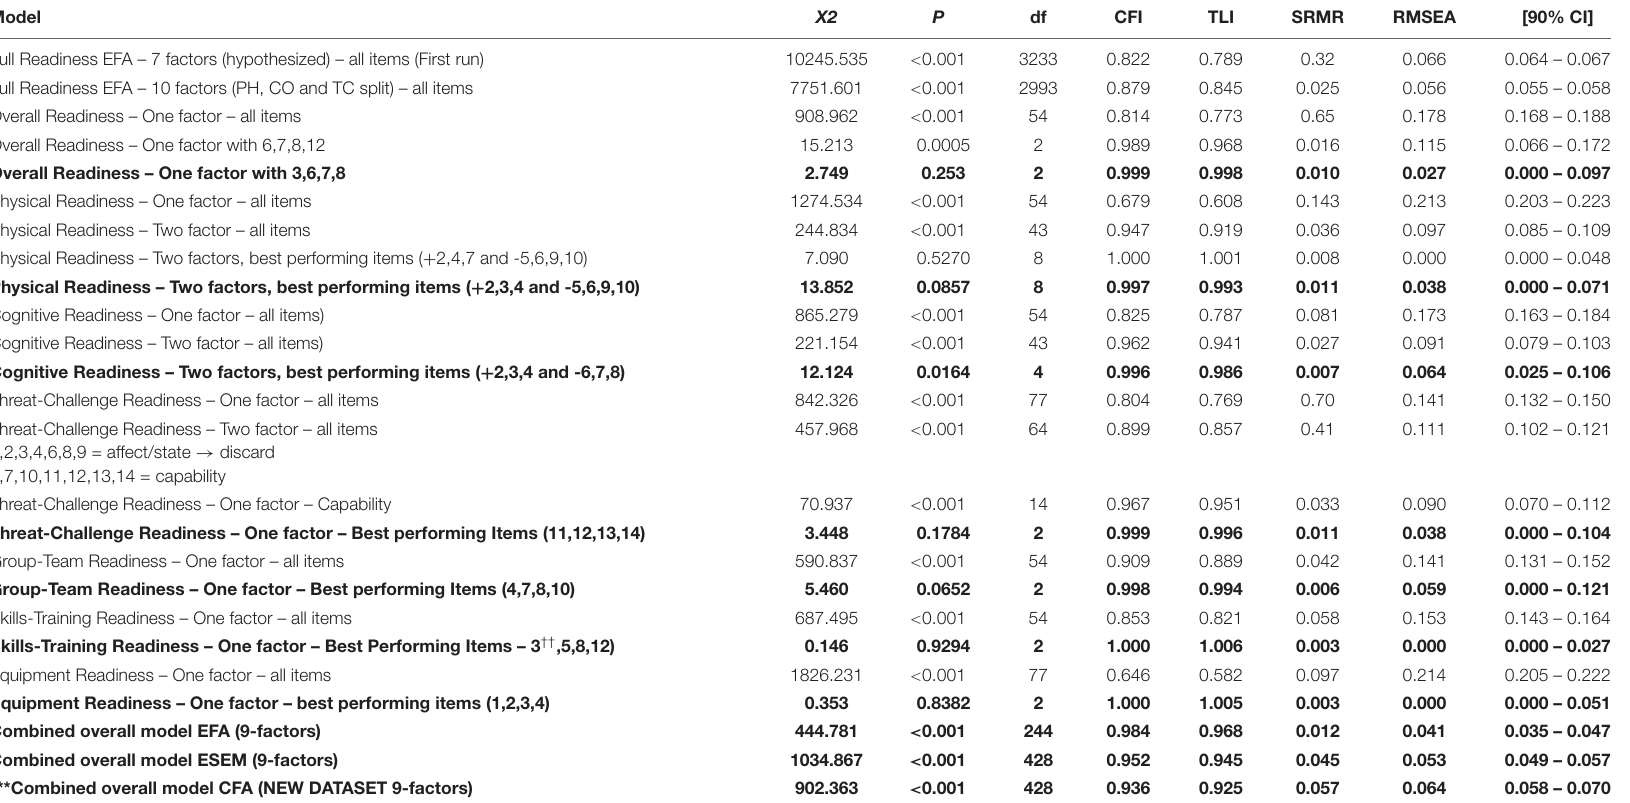
TABLE 2 | Model fit indices of different models developed during the ESEM process.